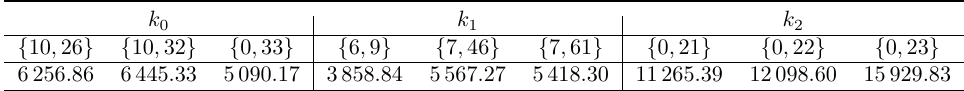
Table 5: Time for retrieving superpolys of the founded valuable cubes. “ { 10 , 26 } ” refers to the cube indexes { 0 , 1 , . . . , 79 } \ { 10 , 26 } , and the time is given in